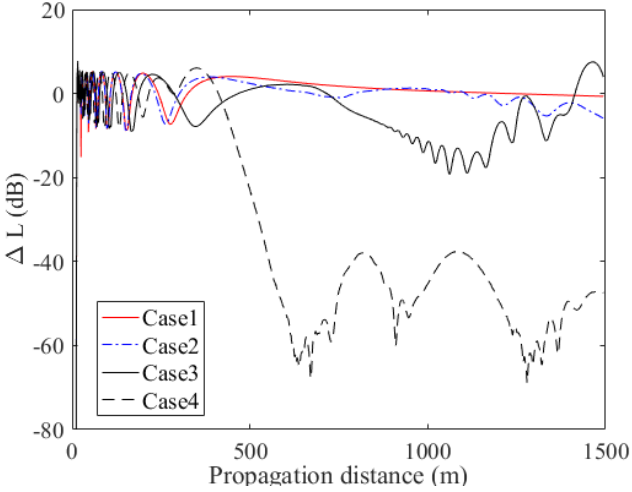
Figure 14. The RSPL at 2 m height extracted from four cases of Figure 13.